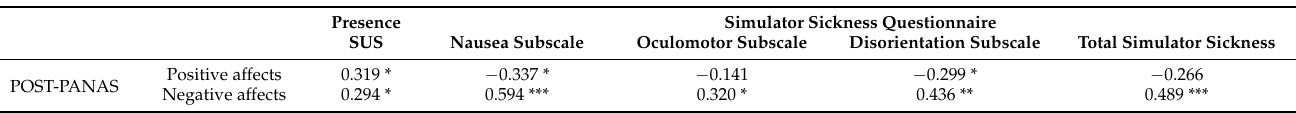
Table 3. Spearman’s correlations between the analyzed individual factors and reported sense of presence and experienced degree of simulator